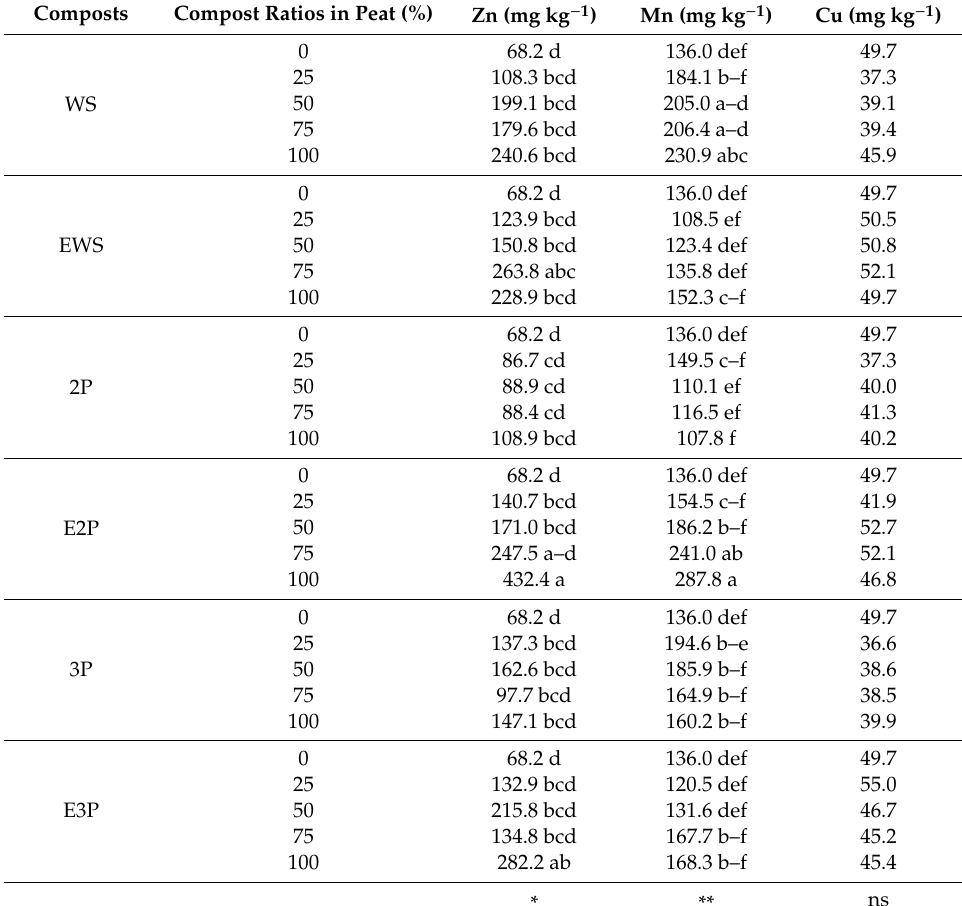
Table 4. Micro nutrient concentrations of the growing medium before seed sowing.